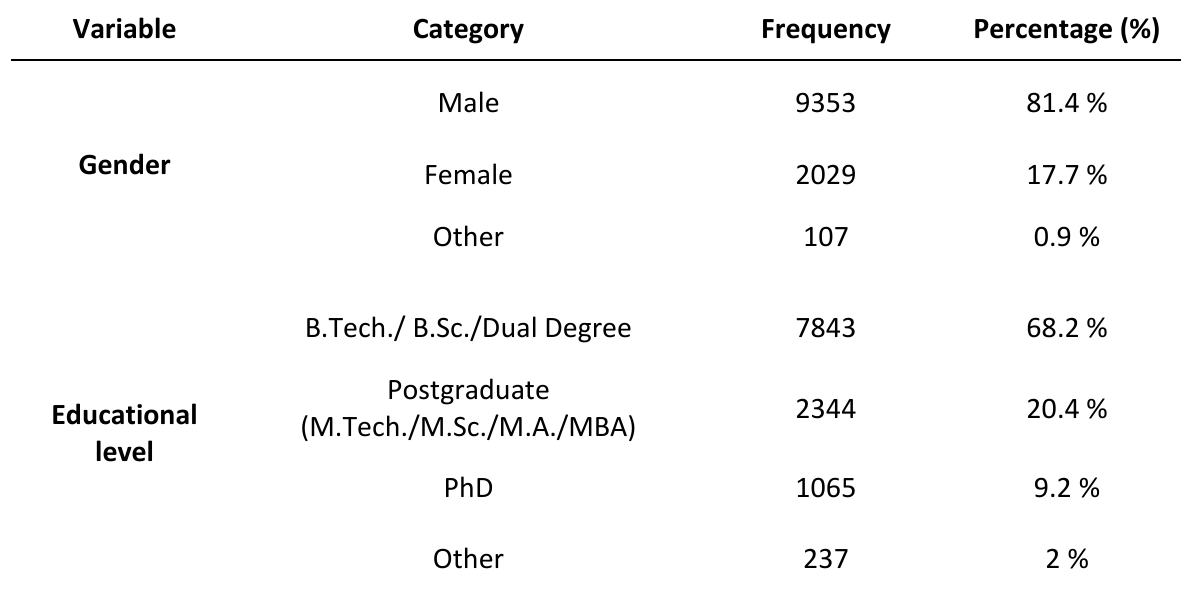
Table 1 : Learners’ demographic characteristics from pan -IIT study Variable